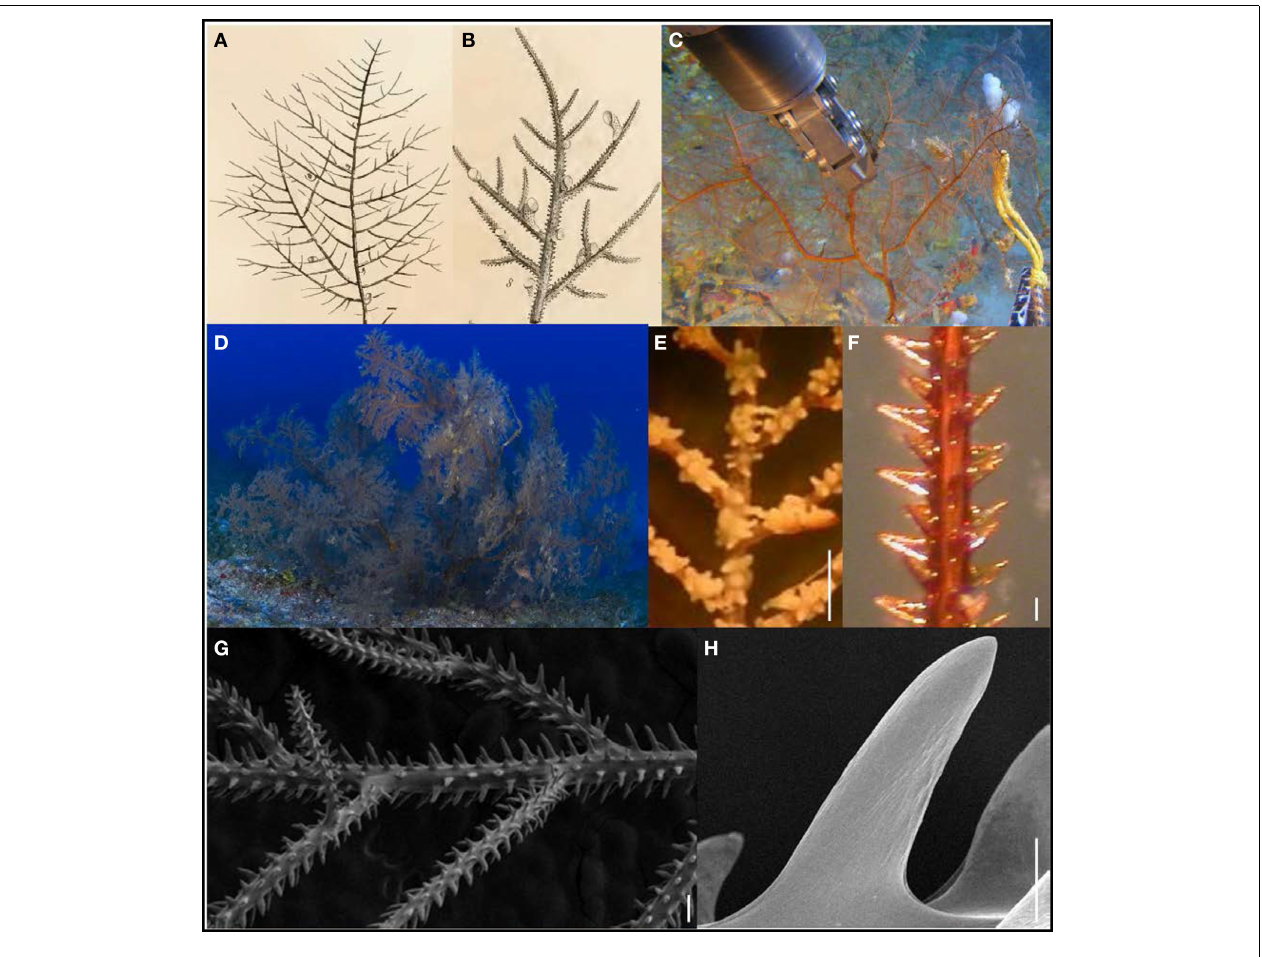
FIGURE 8 | (A,B) Plates accompanying the original description of Myriopathes ulex (Ellis and Solander, 1786), a species for which the type material is now lost. (C,D) In situ photographs of colonies from Hawaiian waters; (E) preserved polyps of Hawaiian species under light microscopy